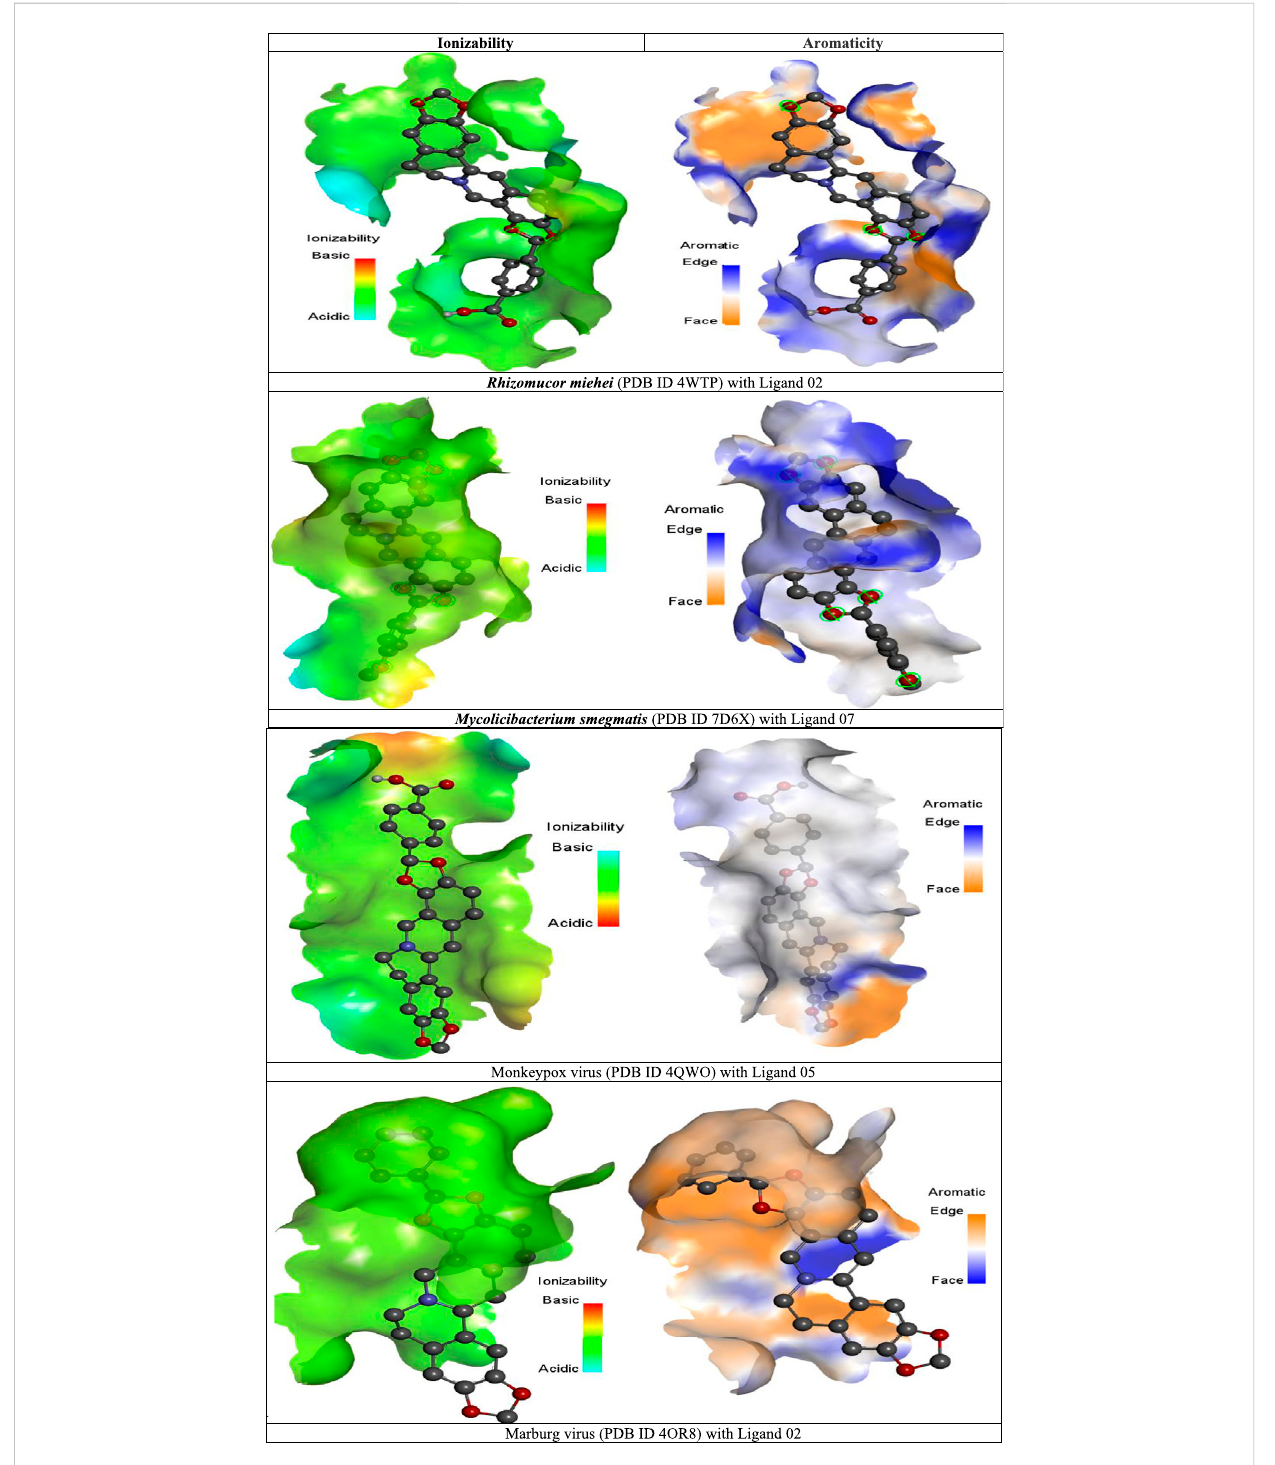
FIGURE 5 Graphical illustration of ionizability, and aromaticity